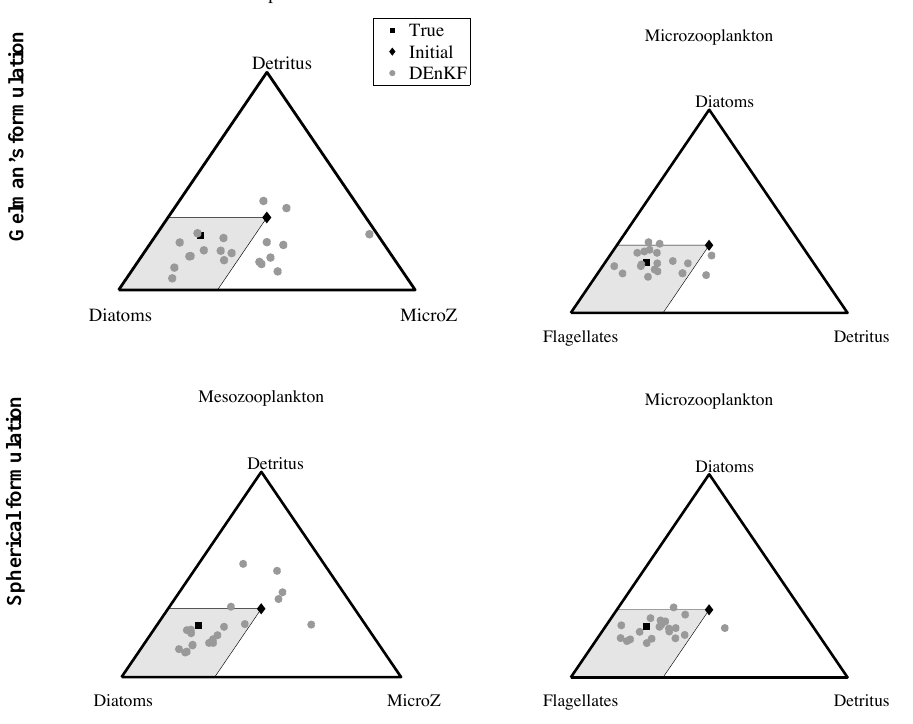
Fig. 5. Ternary plots of the final estimate (mean of the ensemble) of the grazing preferences parameters for the 20 experiments. The estimates obtained after assimilation are plotted with grey circles, the true set of parameters with a black square and the mean of the background set of parameters with a black